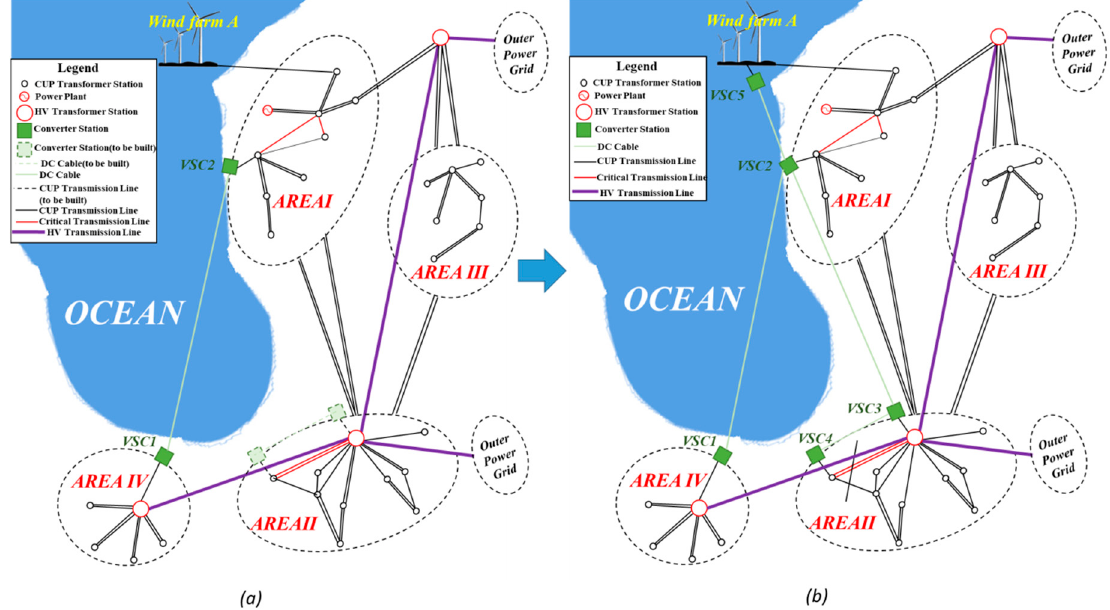
Figure 7. System structure of the five-terminal CU-MTDC. ( a ) Initial coastal urban power grid. ( b ) Final CU-MTDC applied in a coastal urban power grid.